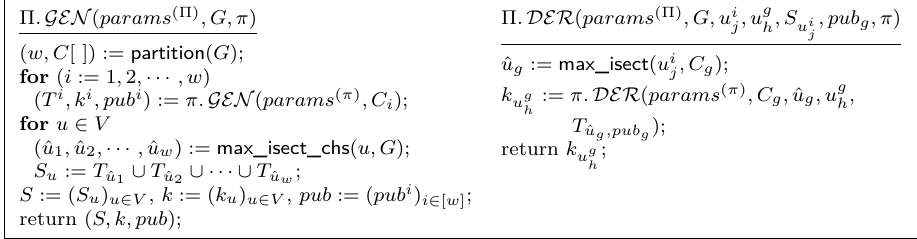
Figure 5: Chain partition algorithm for building KAS . The functions partition , max_isect_chs and max_isect are described in Subsubsection